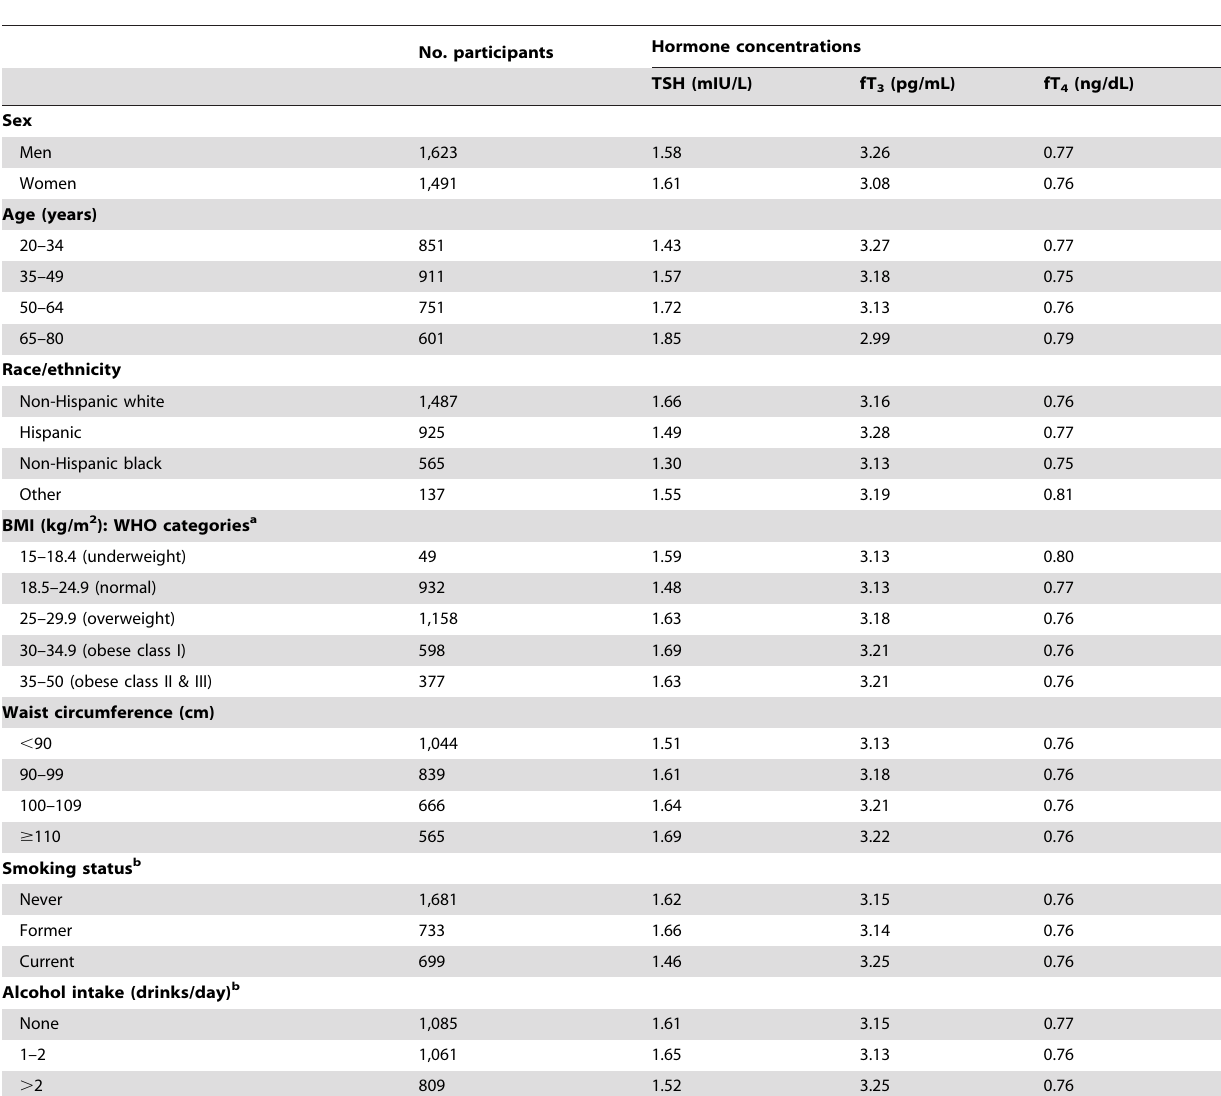
Table 1. Geometric means for TSH, fT 3 , and fT 4 levels by select characteristics of male and female participants, NHANES 2007– 2008.